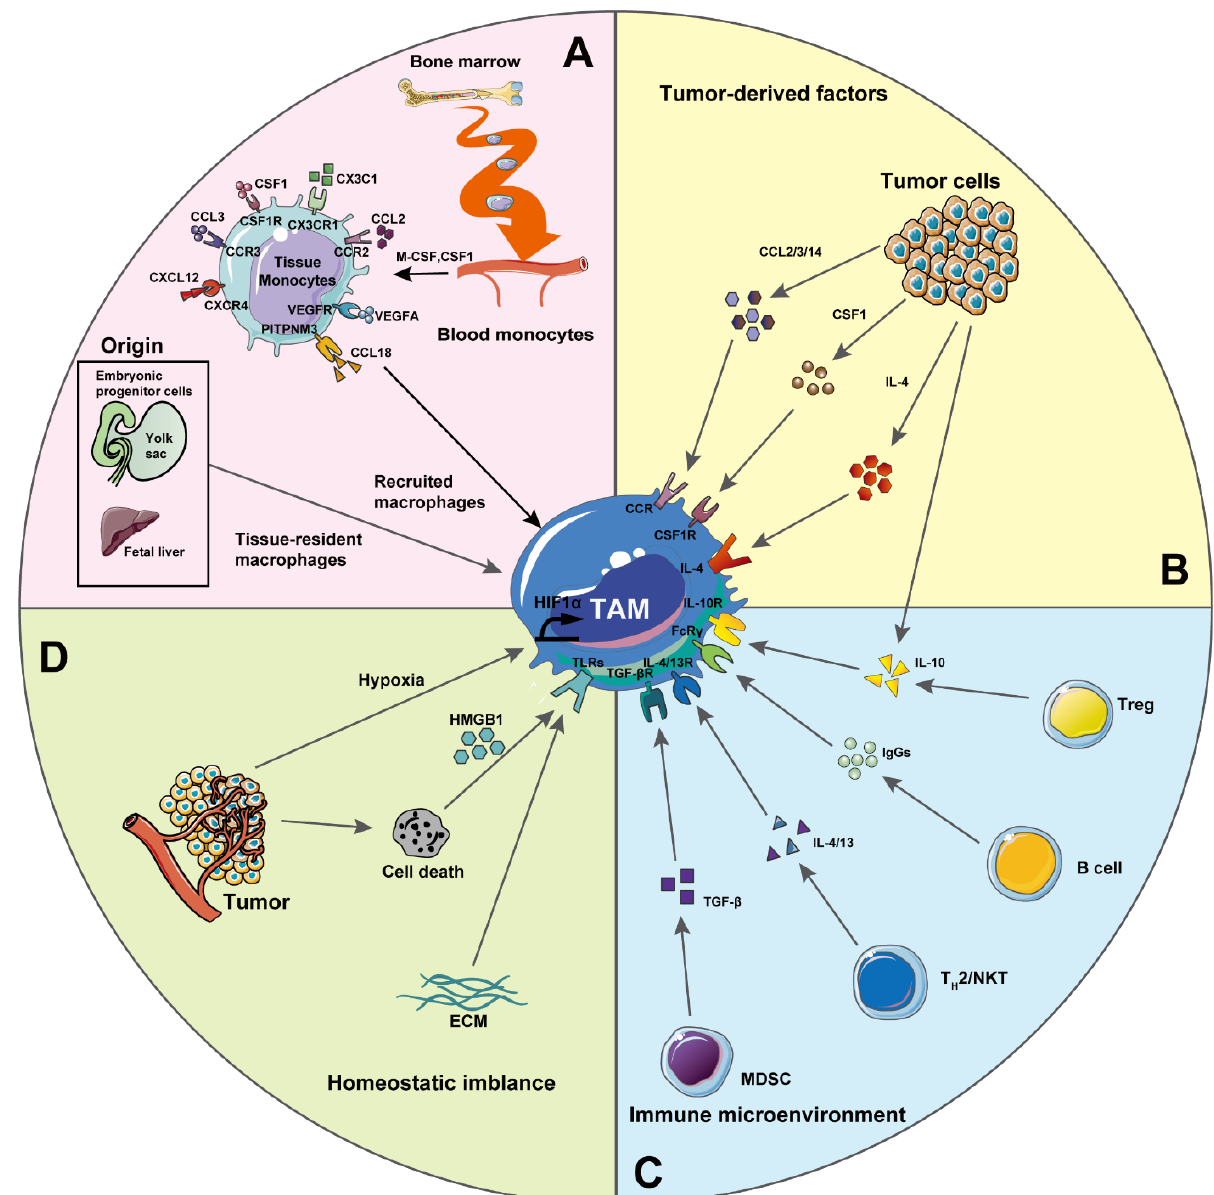
Figure 2. The origin and polarization state of tumor-associated macrophages (TAMs) in the tumor microenvironment (TME). ( A ) Origin: TAMs in the tumor are largely derived from blood monocytes that have their origin in hematopoietic stem cells in the bone marrow, or, at minor contributions, from locally derived, tissue-resident macrophages with their origin in progenitor cells generated in the fetal liver and yolk sac during embryonic development. ( B ) Tumor-derived factors: tumor cells can produce a variety of factors (such as CCL2/3/4, CSF1, IL-4 and IL-10) that act on the polarization of TAMs. ( C ) Immune microenvironment: Treg-derived IL-10, MDSC-derived TGF β , B-cell-derived Ig, Th2-derived IL-4 and NK-cell-derived IL-13 enhance the M2-like (immunosuppressive) phenotype of TAMs. ( D ) Homeostatic imbalance: Hypoxia promotes the malignant transformation of tumors under the action of hypoxia-inducible factors. Tumor-derived ECM and HMGB1 increase the number of TAMs. The abbreviations are CSF1, colony-stimulating factor 1; CSF1R, CSF1 receptor; ECM, tumor-derived extracellular matrix; HMGB1, high-mobility group box 1 protein; Tregs, regulatory T cells; Ig, immunoglobulin; TGF, transforming growth factor; IL, interleukin; TNF, tumor necrosis factor; VEGF, vascular endothelial growth factor; VEGFR, VEGF receptor; MDSCs, myeloid suppressor cells; TLR, Toll-like receptor; CCL, chemotaxis chemokine ligand; CXCL, chemokine; and CXCR, chemokine receptor. This figure was prepared using a template on the Servier medical art website (http://www.servier.fr/servier-medical-art, accessed on 10 June